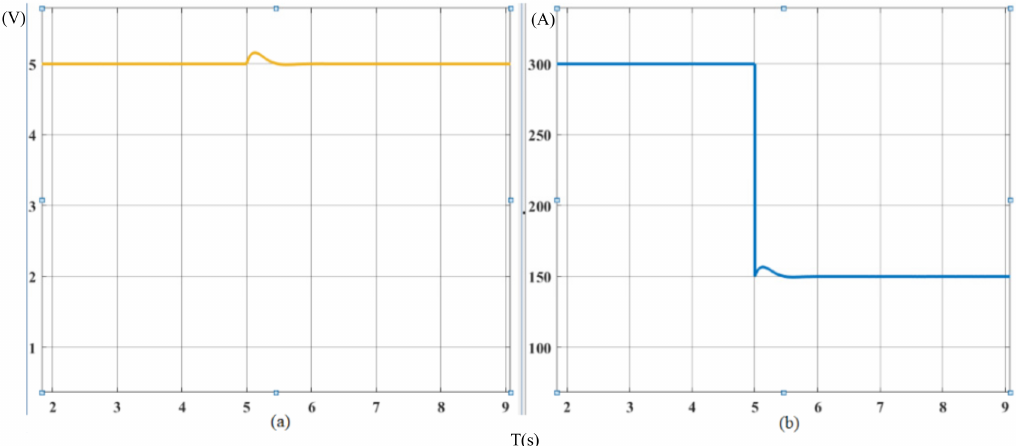
Figure 17. DC output waveforms controlled by the nonlinear feed-forward PID control method when the load suddenly decreases: ( a ) voltage waveform; ( b ) current waveform.